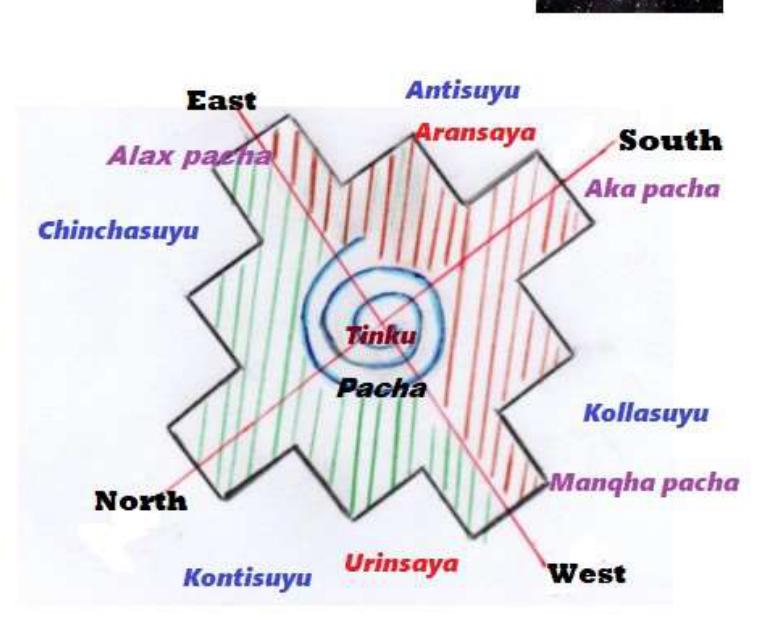
Figure 2: Interpretation of the Chakana. Elaboration by Yaneth K. Apaza